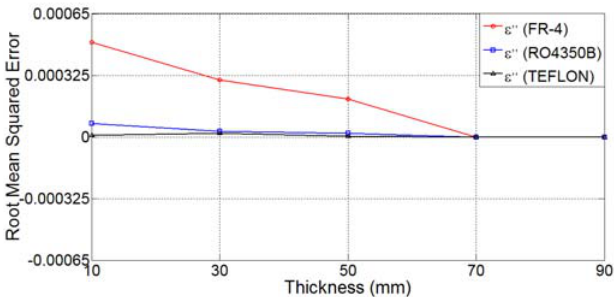
Figure 11: Root mean squared error versus thickness graph for